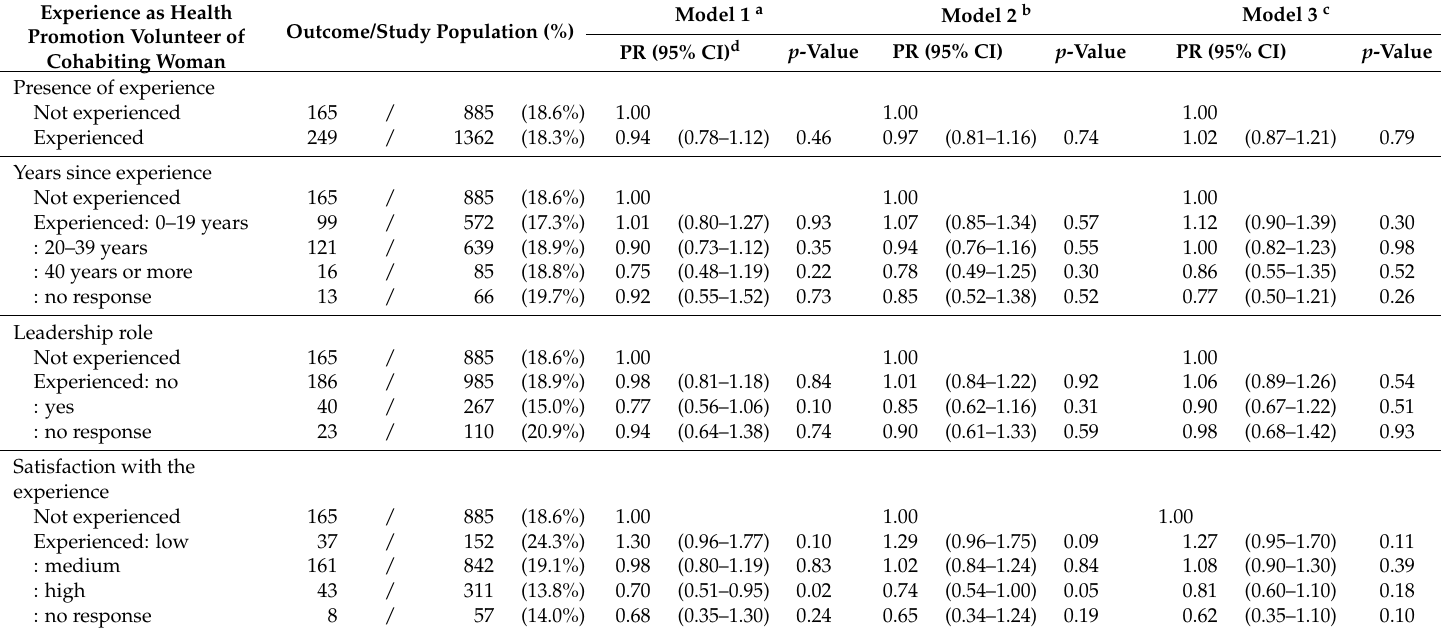
Table 2. Association between cohabiting women’s experience as a health promotion volunteer and low functional capacity in the study population ( n =